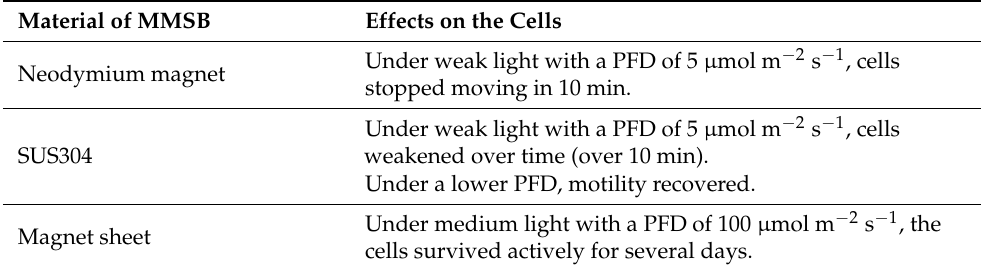
Table 2. Effect of MMSB on cells.